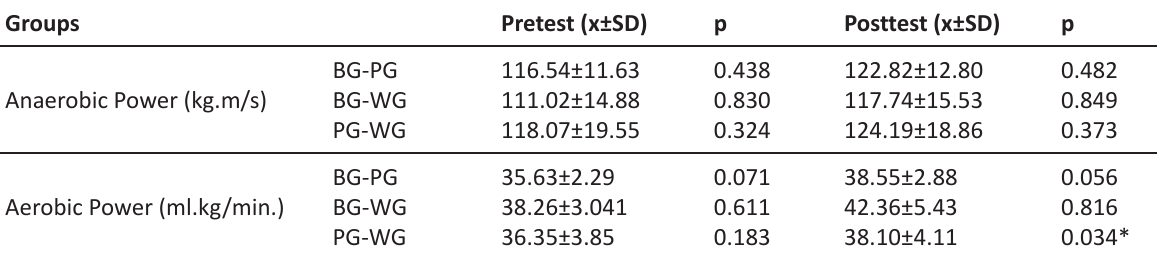
Table 3. Comparison of aerobic and anaerobic power pretest-posttest among groups Groups